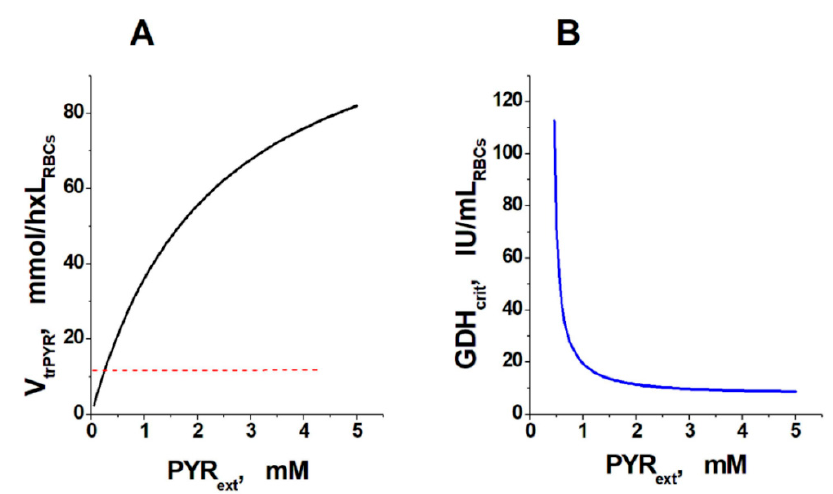
Figure 1. Effect of plasma pyruvate concentration (PYR ext ) on the rate of pyruvate influx into the cell (V trPYR ) and the critical activity of GDH that can be incorporated into erythrocytes (GDH crit ). ( A ) Dependence of the pyruvate influx rate into erythrocytes, which corresponds to the maximum possible ammonium consumption rate, on the pyruvate concentration in plasma. The concentrations of all other metabolites are physiological. The critical ammonium consumption rate (values exceeding this lead to the disappearance of the steady state in glycolysis) is depicted by the red dashed line. ( B ) Dependence of the critical activity of GDH (corresponding to the critical rate of ammonium consumption, represented by the dashed line in panel A), which can be encapsulated in erythrocytes without loss of the steady state in glycolysis, on the concentration of pyruvate in the medium.